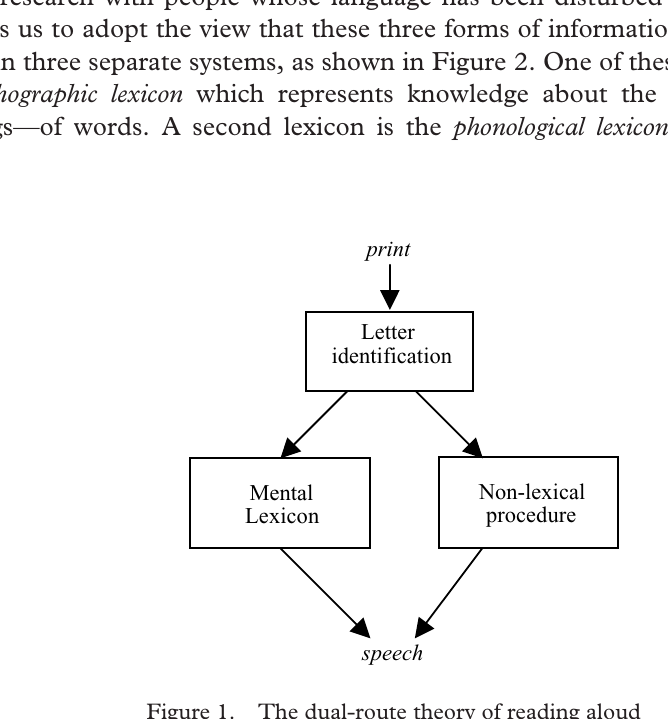
Figure 1. The dual-route theory of reading